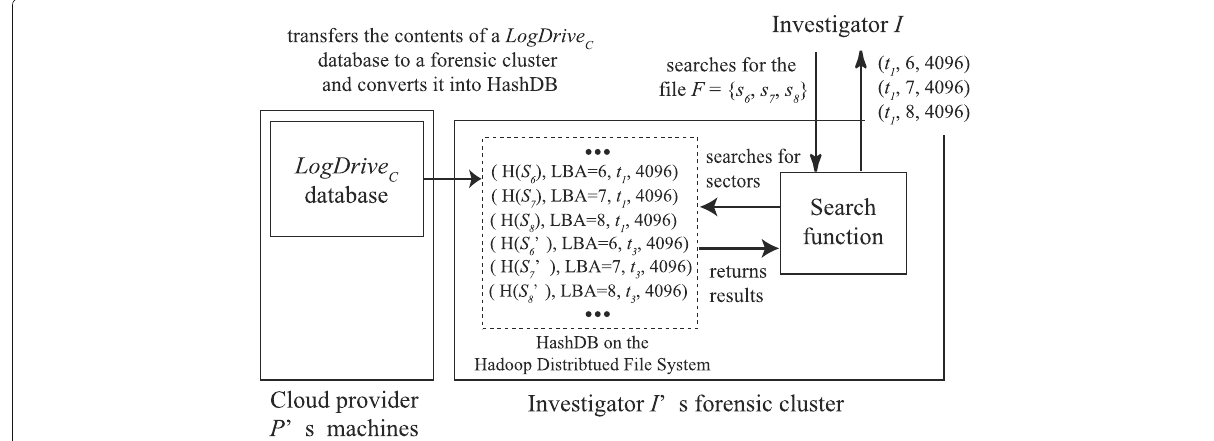
Fig. 4 System model of the file search